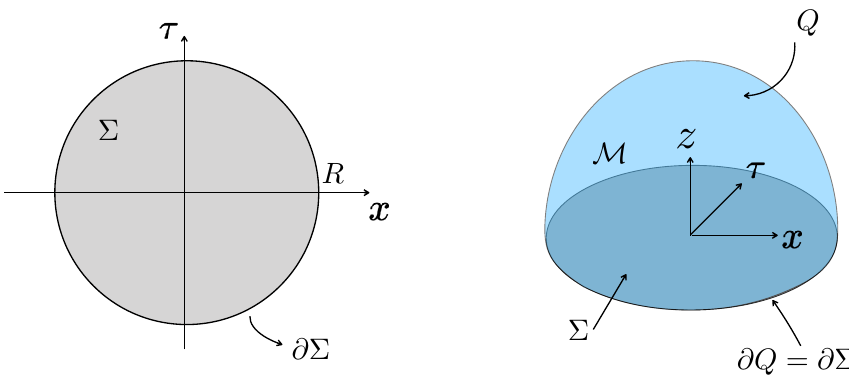
Figure 2 . BCFT defined on a disk (left) and its gravity dual (right).